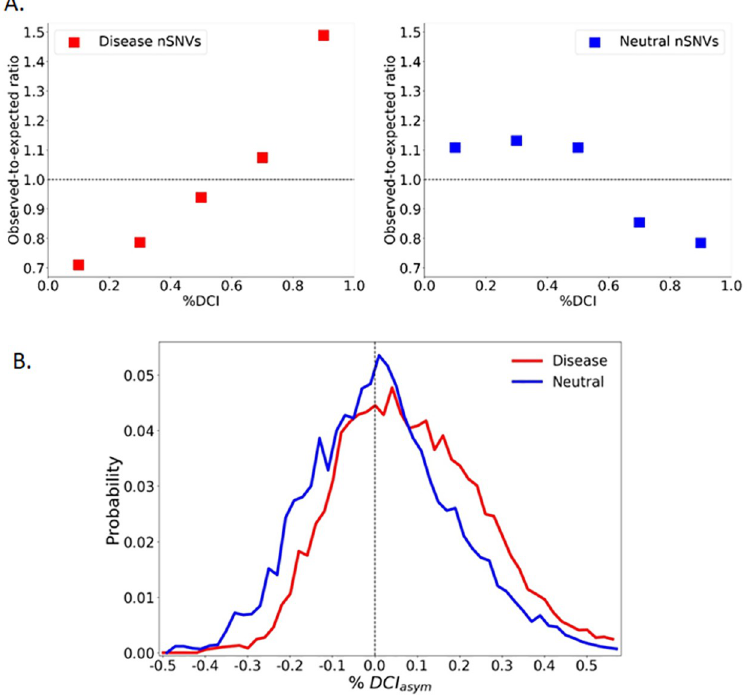
Fig 5. %DCI and asymmetry for 144 protein ensemble. ( a ) Throughout 144 proteins and 1024 variants’ sites within those proteins, %DCI values were determined. These distributions were compared with the expected null distribution that %DCI values would be equally distributed over all investigates sites. Observed-to-expected ratios reveal that there are more DAVs than expected having high %DCI, whereas fewer neutral variants than expected are observed in high % DCI categories. Above the ratio equal to 1, the DAV or neutral variants occurs more often than the null expectation. Below the ratio of 1, the mutation does not occur as often as expected. ( b ) Comparison of %DCI asym of sites associated with neutral variants and DAVs. The distributions show a contrast as DAV sites tend to exhibit more positive values ( P < .001), suggesting that the active site dominates the coupling. Neutral sites on the other hand tend to give more negative asymmetry values, suggesting that the mutation site dominates. A moving average was used to visually smooth the distribution.